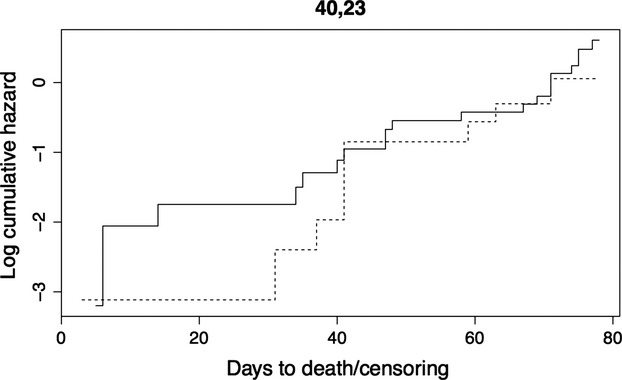
Hazard curves of females from line 40, 23 after experiencing homotypic (solid line) or heterotypic (dashed line) matings.